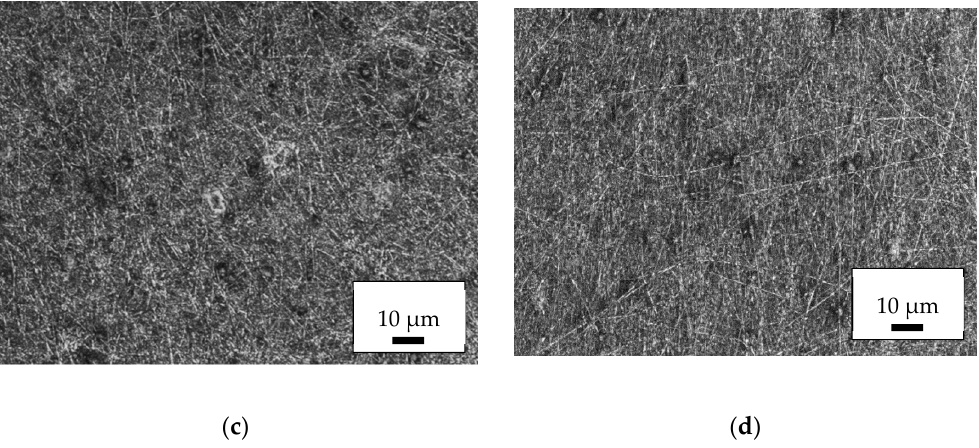
Figure 5. CLSM (confocal laser scanning microscopy) images of the PAN/magnetite nanofiber mats with different polymer:nanoparticle weight ratios: ( a ) 1:0.38; ( b ) 1:0.79; ( c ) 1:1.25; ( d ) 1:1.8. CLSM images of PAN/diiron nickel tetraoxide nanofiber mats are depicted in Figure 6. On the one hand, all nanofiber mats show larger variations of the fiber distribution, partly even connected with holes in the mats. On the other hand, more and larger beads are visible.